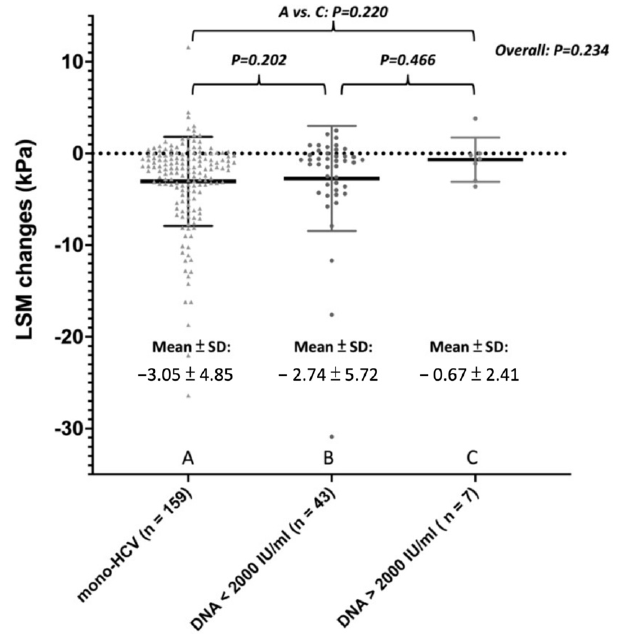
Figure 1. Liver stiffness measurements change after SVR among patients with mono-HCV, co-infection with inactive HBV, or co-infection with active HBV.